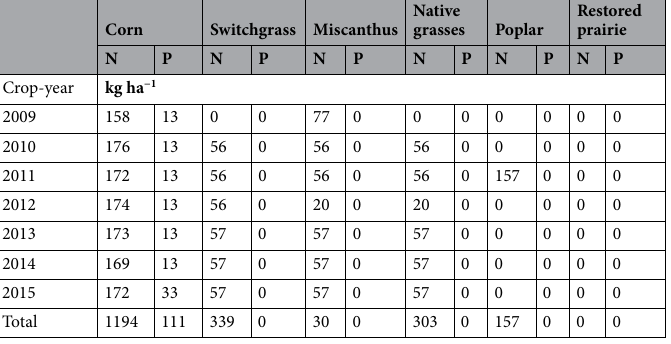
Table 1. Nitrogen (N) and phosphorus (P) fertilizer applications (kg ha −1 ) to the cropping systems.